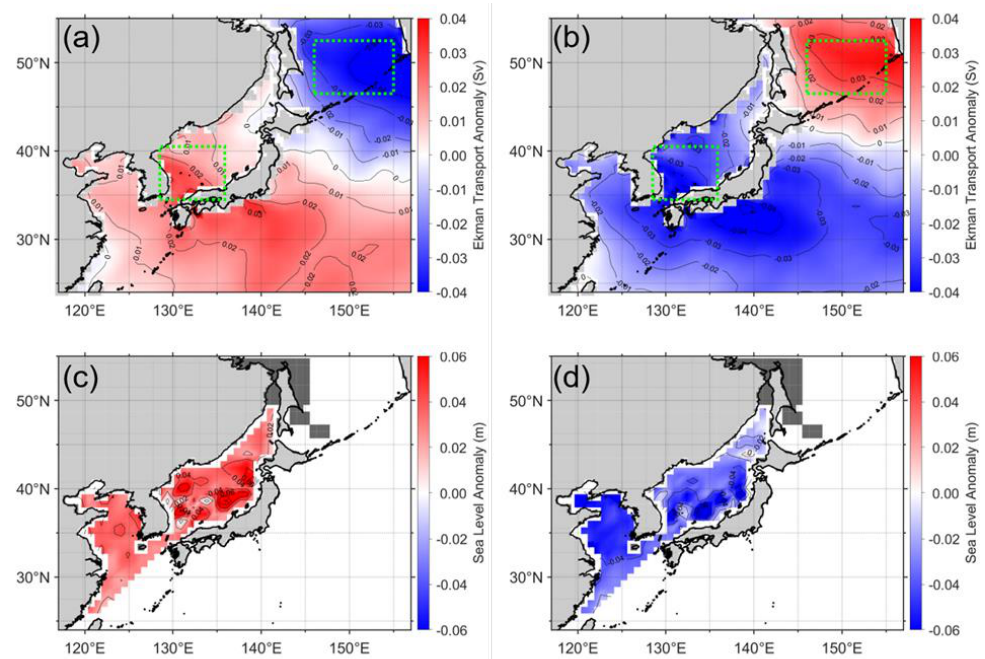
Figure 6. The horizontal Ekman transport anomaly in Sv during ( a ) Period H and ( b ) Period L. Positive sign means eastward and northward Ekman transport anomaly. The areas of WA and WB are marked with green dotted boxes. The sea level anomaly distribution within the NEAMS area derived from satellite altimetry observations during ( c ) Period H and ( d ) Period L. Light and dark grey colors indicate land and ice areas, respectively.